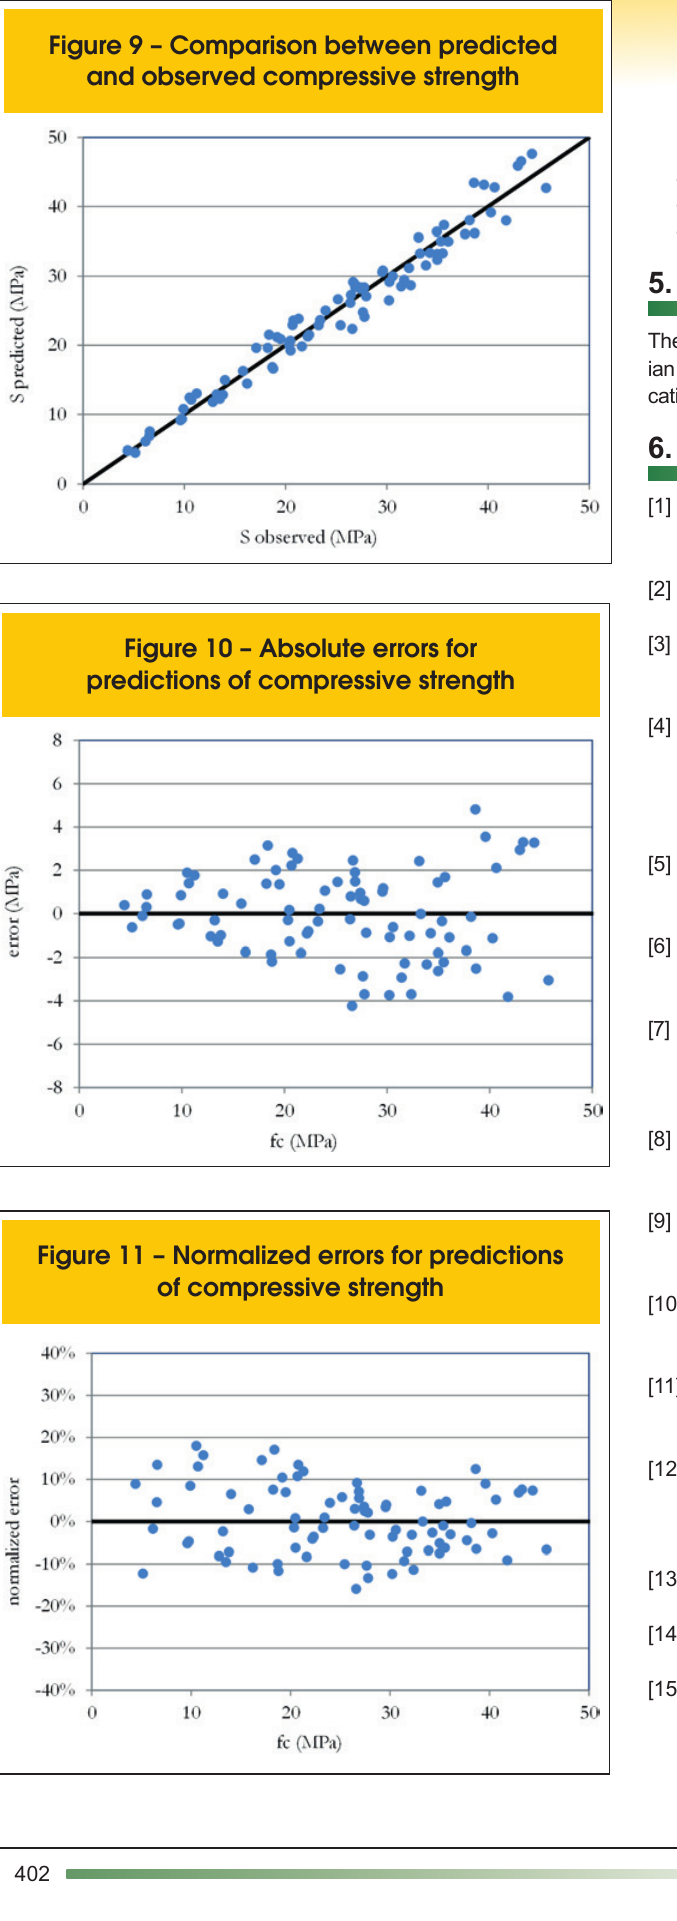
Figure 9 – Comparison between predicted and observed compressive strength